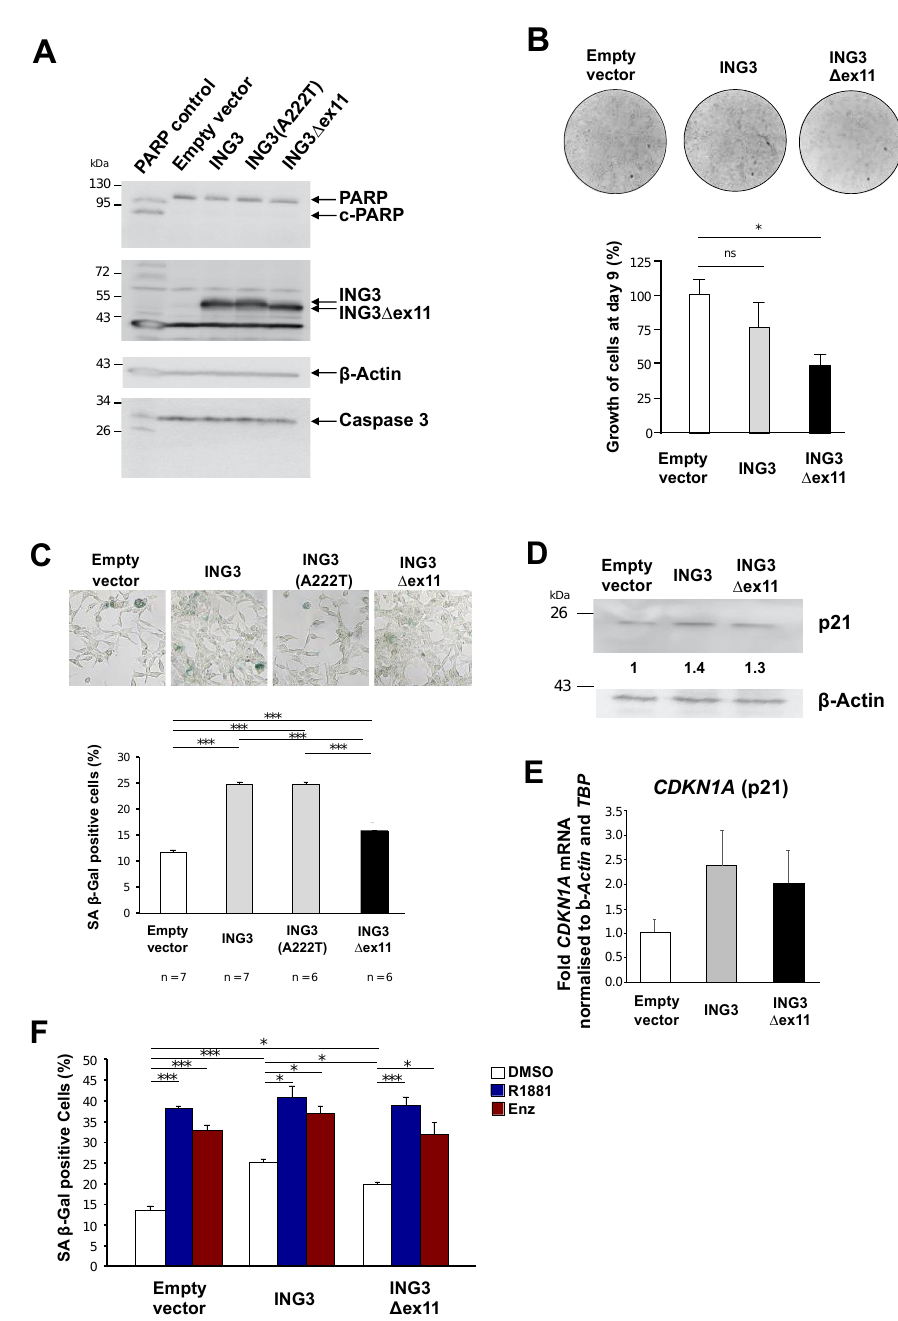
Figure 2. ING3 ∆ ex11 expression inhibits cell growth and induces cellular senescence; LNCaP cells were transfected with indicated expression vectors for ING3, ING3 ∆ ex11, or empty vector as control. ( A ) Western blot indicates the lack of apoptosis cleaved-PARP (c-PARP) and cleaved caspase 3. ( B ) Growth assays were analysed with crystal violet staining to indicate the inhibition of cell proliferation. ( C ) Cellular senescence was analysed by the senescence marker SA β -Gal activity. ( D ) Western blot indicates the upregulation of the cell cycle inhibitor p21. ( E ) qRT-PCR indicates p21 expression is upregulated by ING3 and ING3 ∆ ex11 at mRNA level. ( F ) Analysis of SA β -Gal activity in the presence of androgen receptor ligands, Enz (enzalutamide) as AR antagonist, R1881 as an AR agonist, and DMSO as solvent control in cells transfected with the indicated expression vectors for ING3, ING3 ∆ ex11, or empty vector as control. p values: p < 0.05 (*); p < 0.01 (**); p <0.001 (***); ns: not